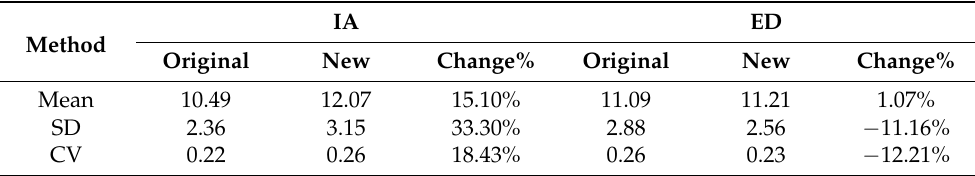
Table 7. Mean, SD and CV of FT4 transformations into the LC-MS/MS scale by piecewise linear transformation.